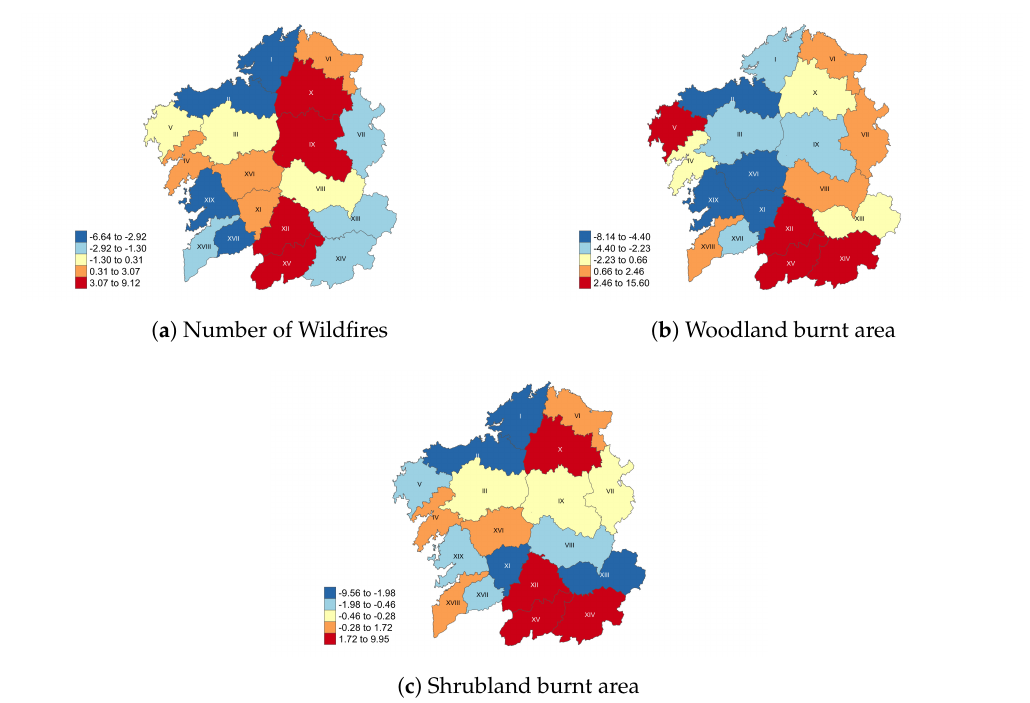
Figure 13. Average elasticity ( × 1000) of the Gini index for each of the Galician forest districts, clustered per